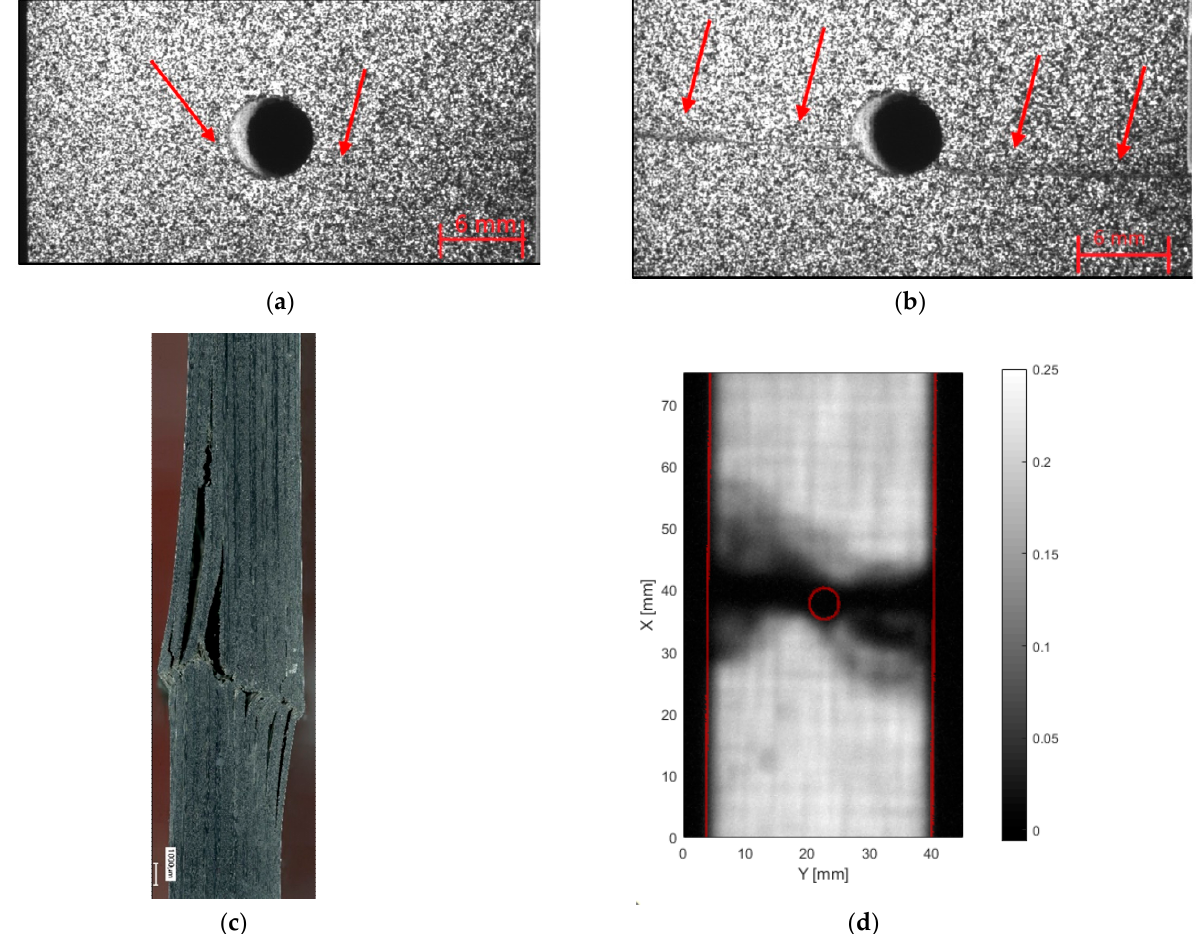
Figure 6. Compressive failure of [0/90] 5s . ( a ) front view just before failure, ( b ) front view after kinking failure, ( c ) side microscopy, ( d ) through transmission ultrasound (for high resolution, please refer to the online version of this article).